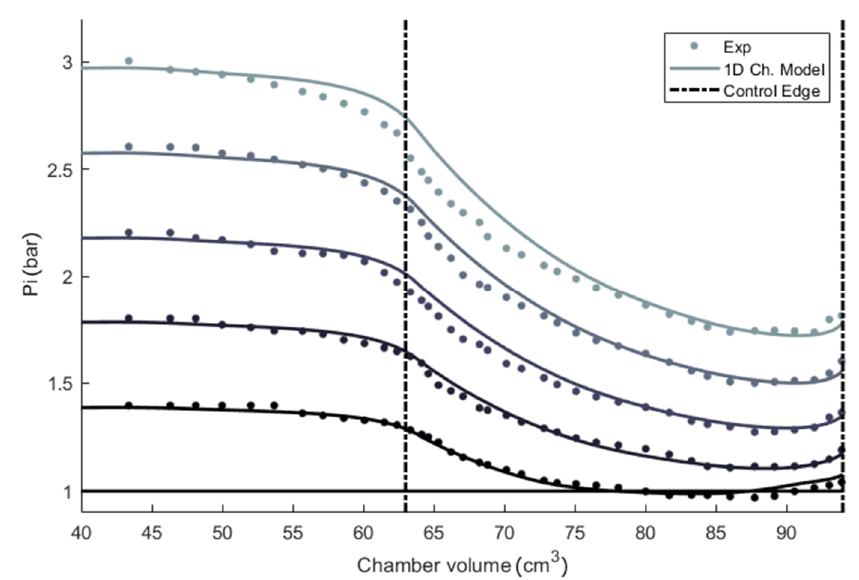
Figure 9. Validation of simulated indicated diagrams for different inlet pressure (n = 10,000 RPM and Ti = 75 °C).